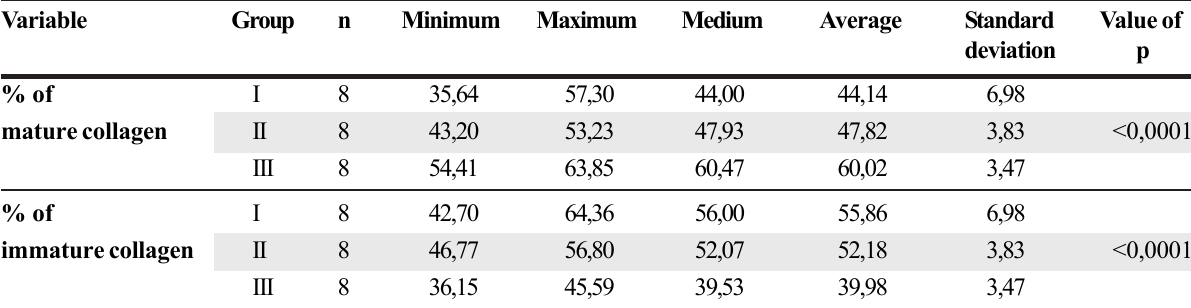
immature collagen